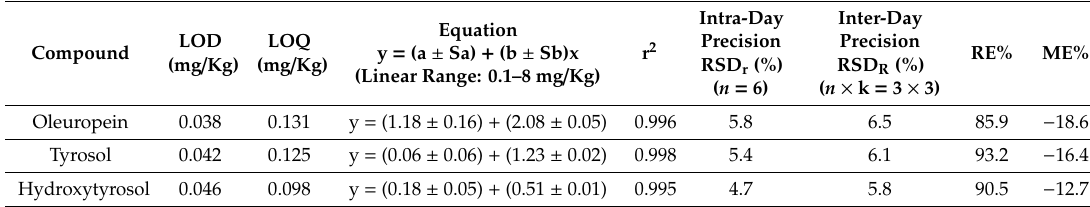
Table 1. Method validation results for